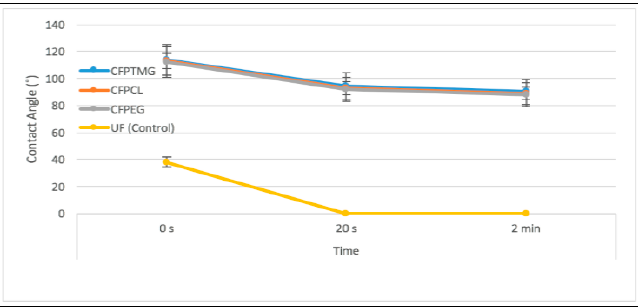
Figure 5. The contact angle of CFPTMG, CFPCL, CFPEG and uncoated with time variation.